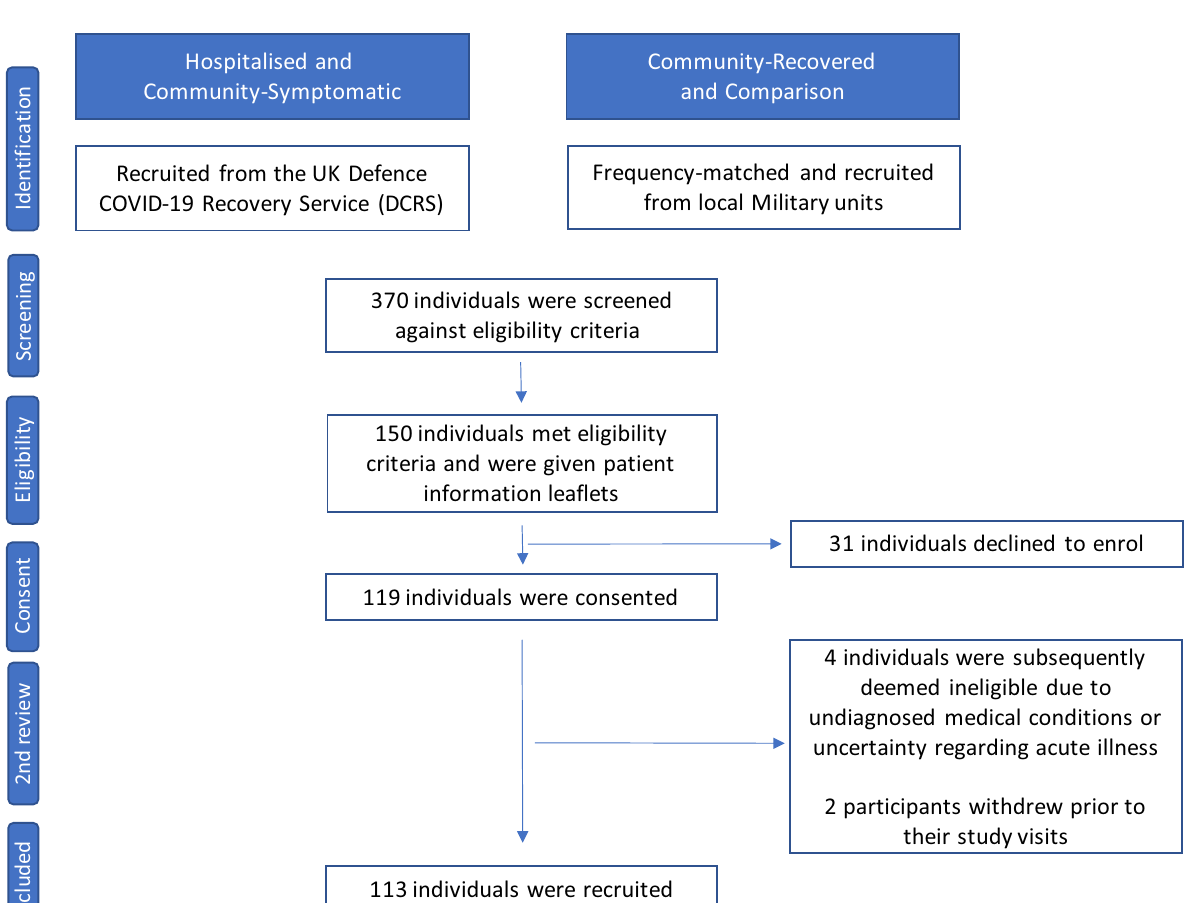
Fig. 2 CONSORT flow diagram of patient